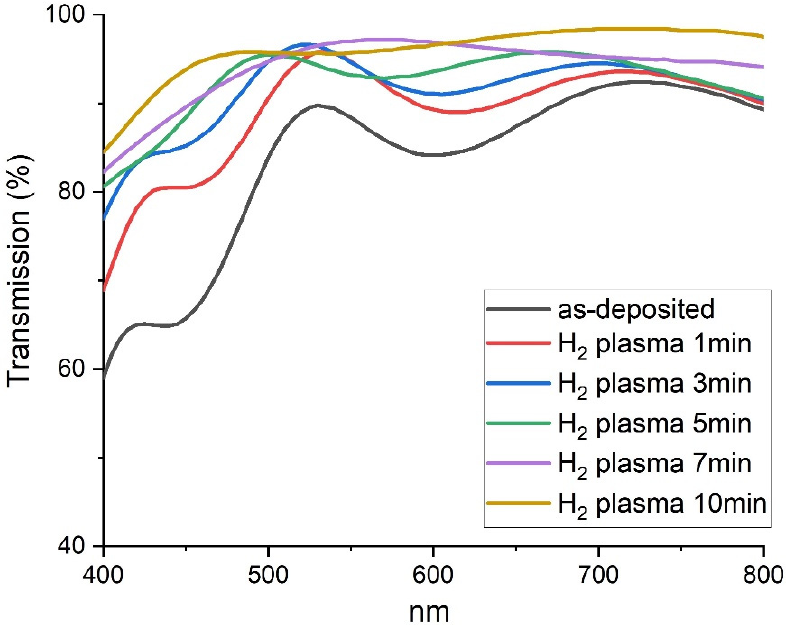
Figure 4. Optical transmittance spectra for the as-deposited and H 2 plasma-processed GAZO films.